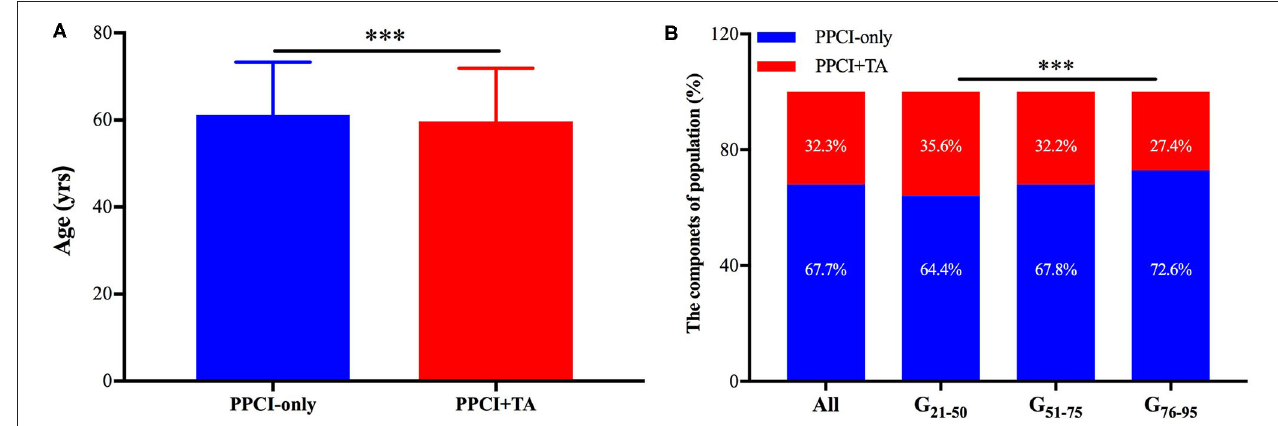
FIGURE 2 | The age-associated utilization of thrombus aspiration. (A) The patients in the PPCI-only group were significantly older than those in PPCI combining thrombus aspiration group. *** P < 0.001. (B) The percentages of STEMI patients undergoing PPCI-only and thrombus aspiration were presented. PPCI, primary percutaneous coronary intervention; TA, thrombus aspiration; CI, confidence